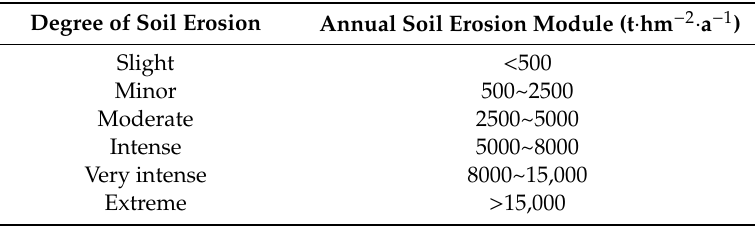
Table 1. Grading standard of soil erosion in the